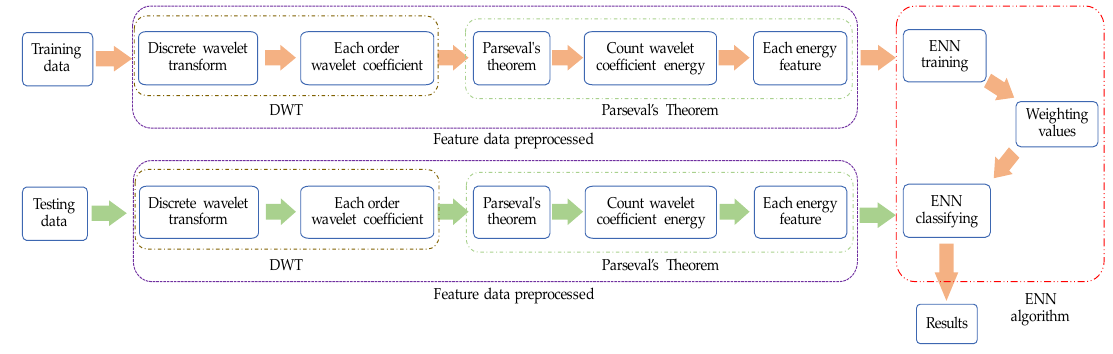
Figure 1 : Flow chart of the proposed system. 111 Figure 1. Flow chart of the proposed